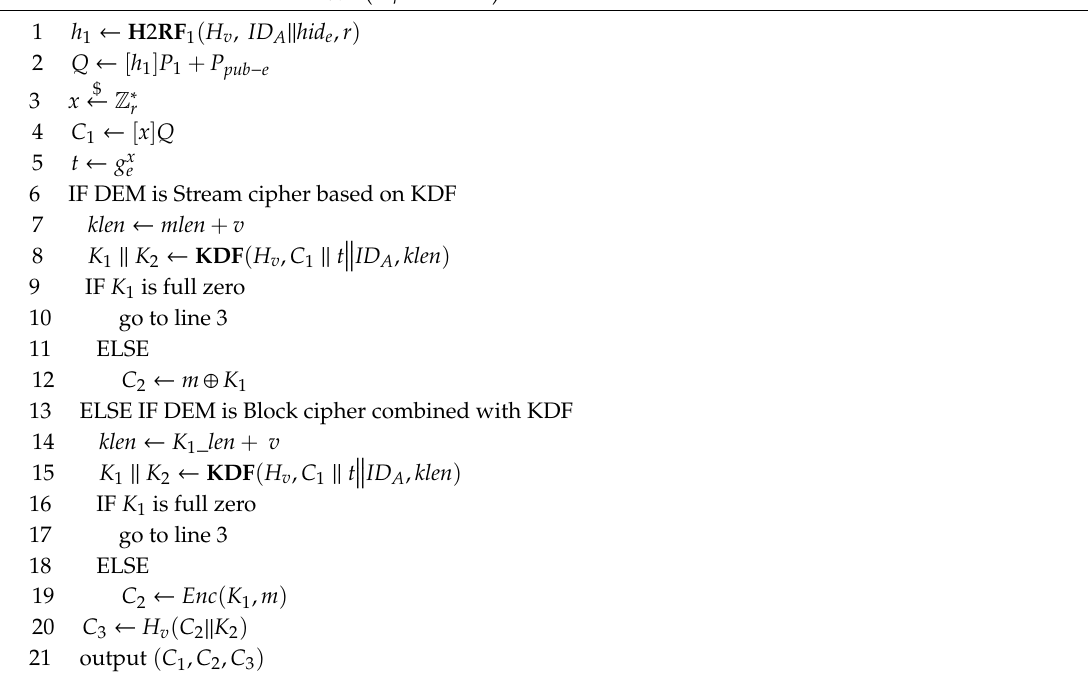
(cid:16) (cid:17) M pk , ID A , m